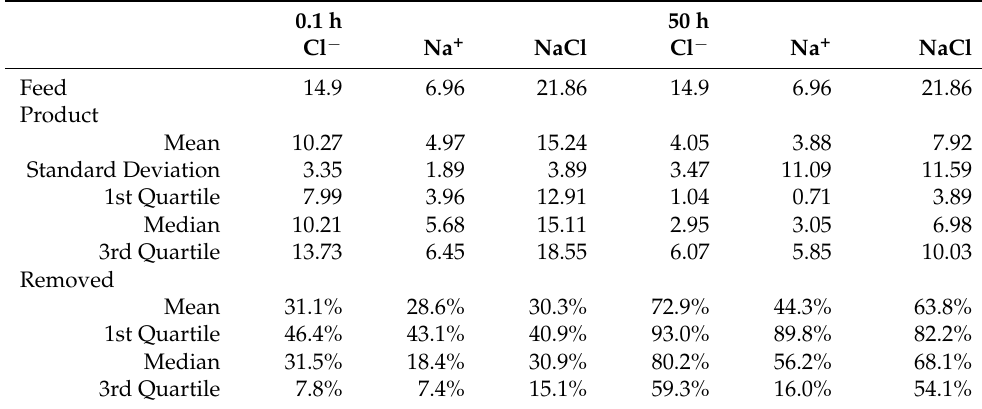
Table 4. Modelled removal of Na + and Cl − ions for Well 1 (Table 1) after 0.1 h and 50 h using a Fe@Ca@Zn polymer (Figure